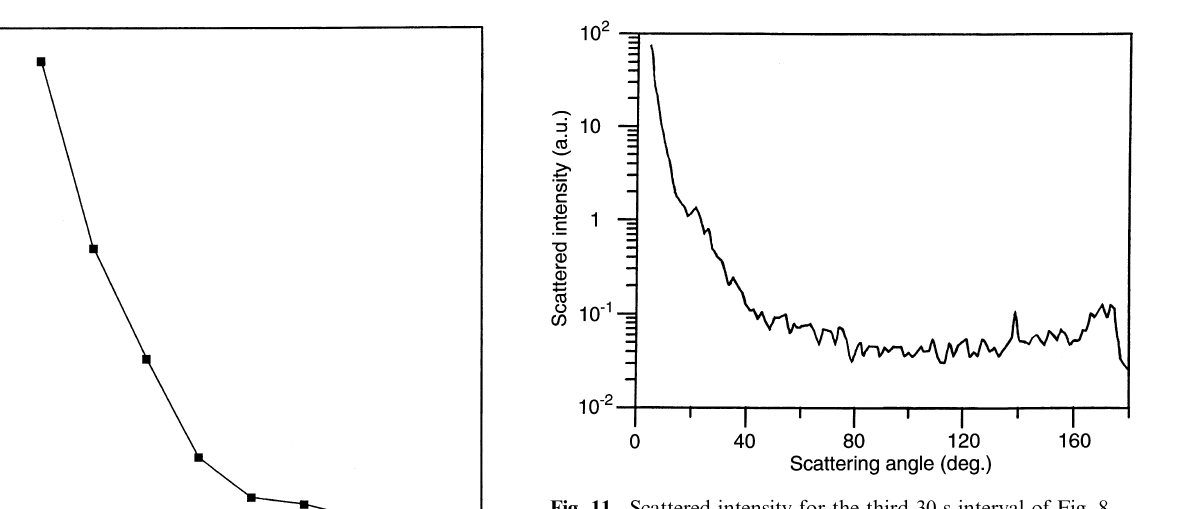
Fig. 11. Scattered intensity for the third 30-s interval of Fig. 8